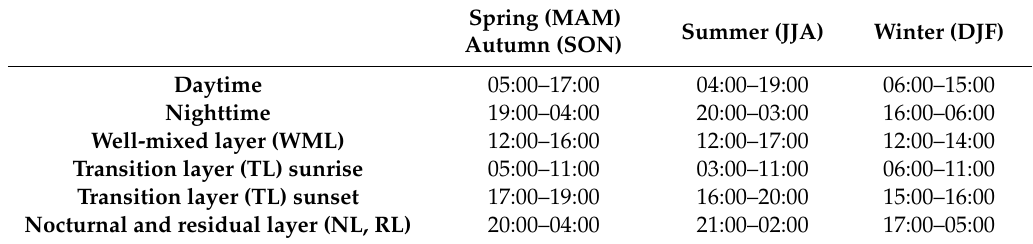
Table 1. The definitions of the time duration for the boundary layer per season used in this study. The given times were assessed as corresponding to the listed periods in di ff erent seasons and do not represent the mean values. Times are given in